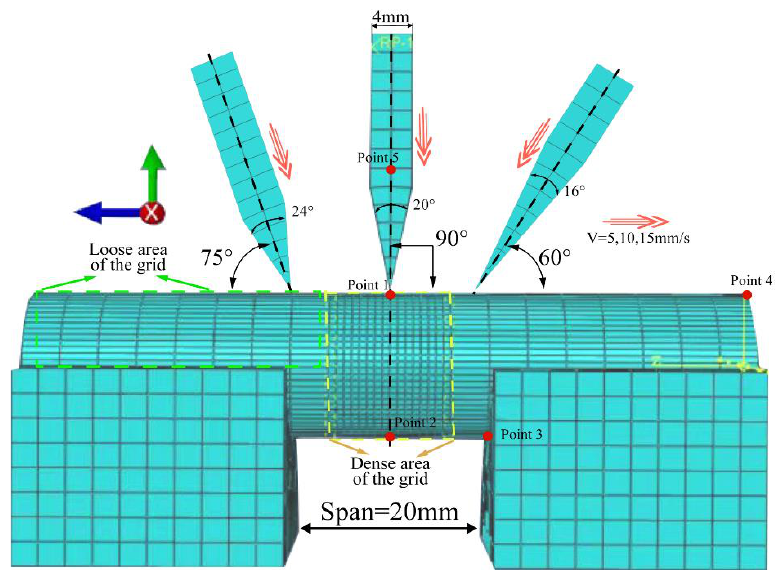
5 of 23 Table 2. Performance parameters of cutting tools. Parameter